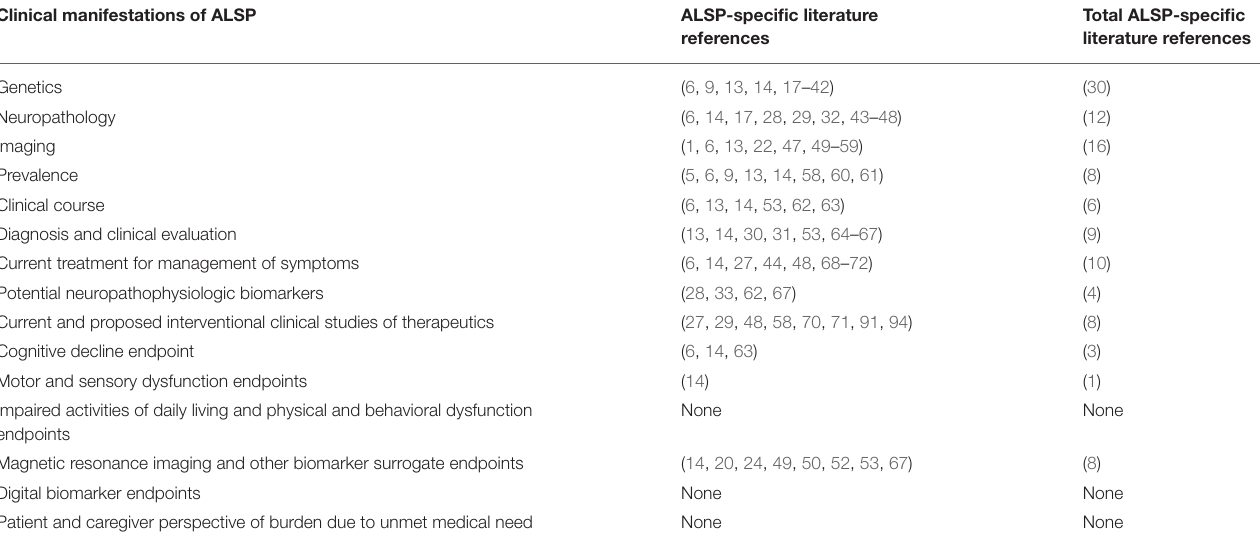
TABLE 1 | Gaps in ALSP specific published literature of clinical